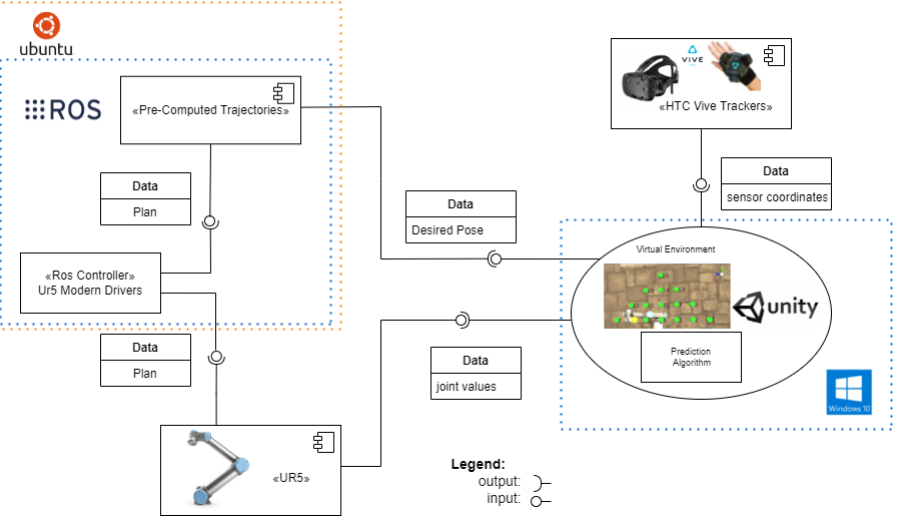
Figure 6. Flowchart of software and hardware